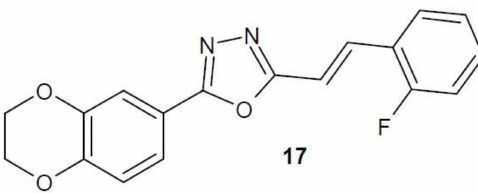
Figure 8. 1,3,4-Oxadiazole derivative with activity of methionine aminopeptidase